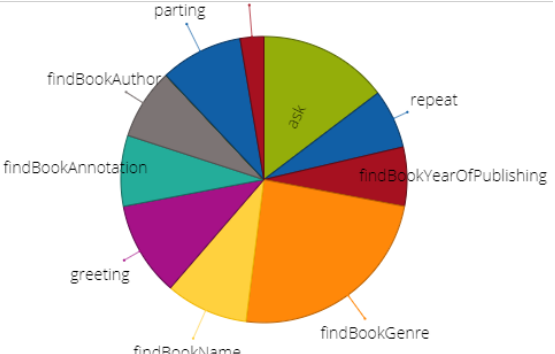
Fig. 4. Recognized Intent Relation